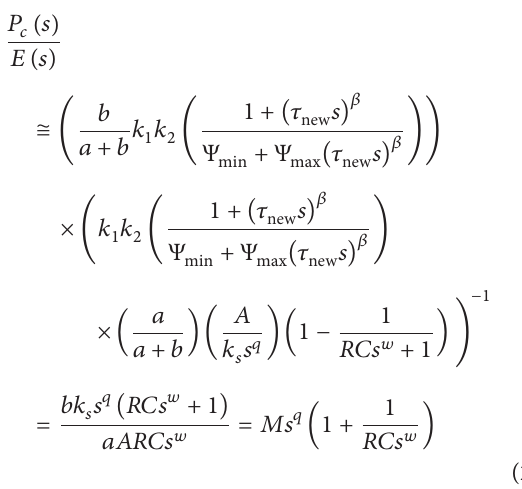
Figure 6: Pneumatic controller with a restriction in the feedback path which depicts an integral